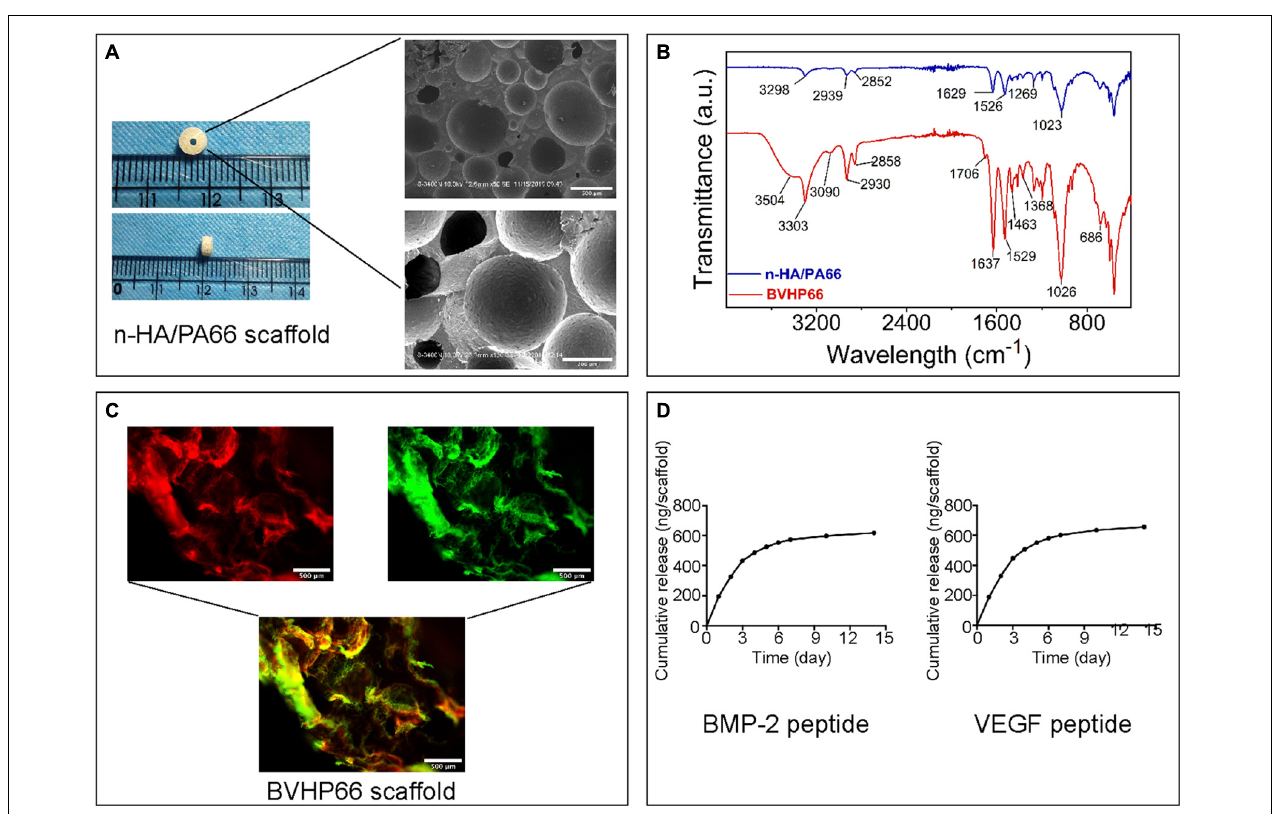
FIGURE 3 | Characteristics of n-HA/PA66 scaffold and BVHP66 scaffold. (A) Macrographs and SEM micrographs of shaped n-HA/PA66 scaffold. (B) FT-IR spectra of n-HA/PA66 scaffold and BVHP66 scaffold. (C) Fluorescent microscope images of rhodamine B-BMP-2 peptide and FITC-VEGF peptide-modified n-HA/PA66 scaffold. (D) In vitro cumulative release profiles of BMP-2 and VEGF peptides from BVHP66 scaffold. Scale bar = 500 and 200 µ m. n = 3 for each